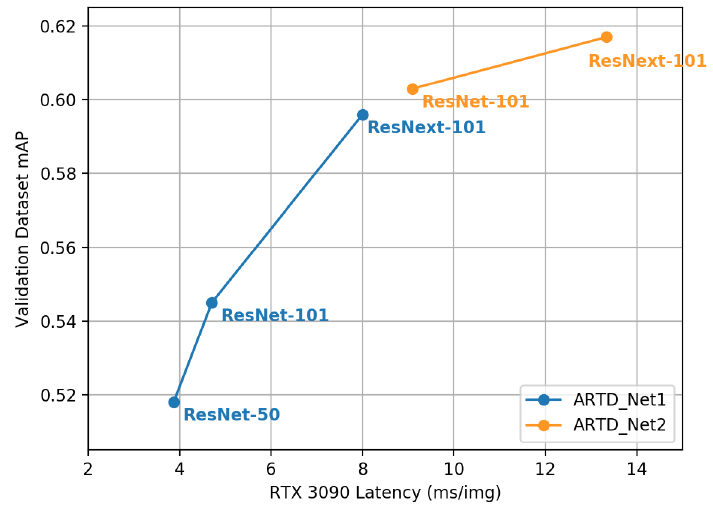
Figure 10. Processing time (ms/img) and accuracy (mAP) using recyclables dataset on ARTD-Net1 and